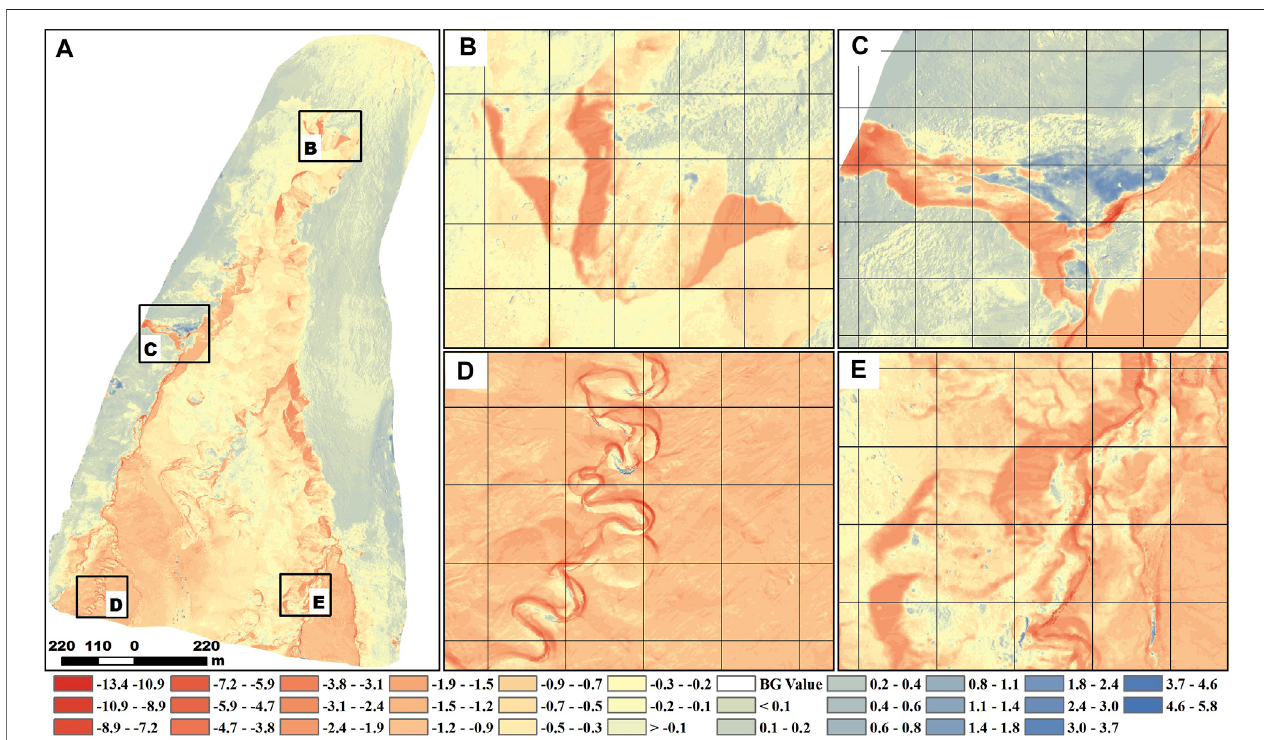
FIGURE 4 | Elevation difference subtracted by DSMs on September 15 minus August 11, with spatial resolution in 3 cm. Rectangles in (A) mark the locations of glacierterminus (B) ,regionwiththelargestsurfaceuplift (C) ,supraglacialriverchannelsin (D) andaside (E) cleaniceregions.Allgridlinesshownasscalereferencearein 30 m